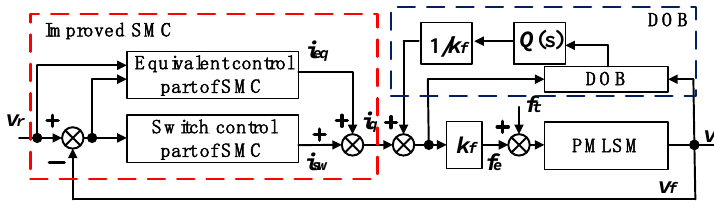
Figure 4. The improved SMC model of segmented PMLSM.